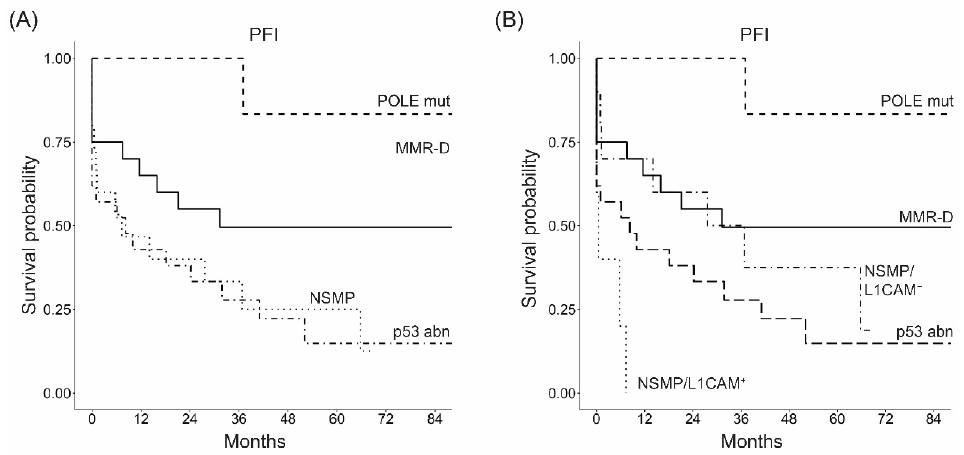
Figure 2. Kaplan–Meier survival curves for platinum free interval (PFI) considering molecular subgroups before ( A ) and after stratifying for L1CAM status within NSMP subgroup ( B ).